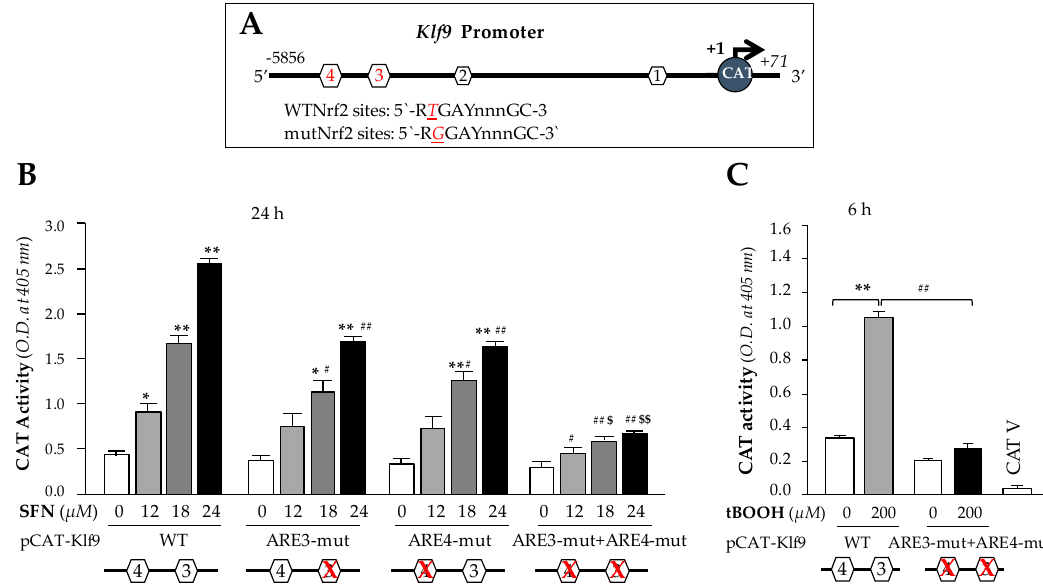
Figure 5. SFN activated Klf9 transcriptional activity through Nrf2 in dose dependent manner. ( A ) Top panel; diagrammatic illustration of Klf9 promoter containing predicted ARE sites with wild type (WT) ARE and mutant sequence (mutated using SDM as described in Materials and Methods). ( B and C ) hLECs were transfected with wild-type Klf9 promoter ( − 5856 /+ 71) or its mutant at ARE3 (ARE3-mut) or at ARE4 (ARE4-mut) and at both ARE3 plus ARE4 (ARE3-mut + ARE4-mut) sites. After 48 h, transfectants were treated with DMSO control or di ff erent concentration of SFN (12, 18 and 24 µ M) for 24 h ( B ) and tBOOH (200 µ M) for 6 h ( C ) as shown, and Prdx6 Promoter activity was measured. * p < 0.05, ** p < 0.001; SFN treated versus untreated control, # p < 0.05, ## p < 0.001; ARE3-mut or ARE4-mut or ARE3-mut + ARE4-mut versus WT, $ p < 0.05, $$ p < 0.001; ARE3-mut + ARE4-mut versus ARE3-mut or ARE4-mut.